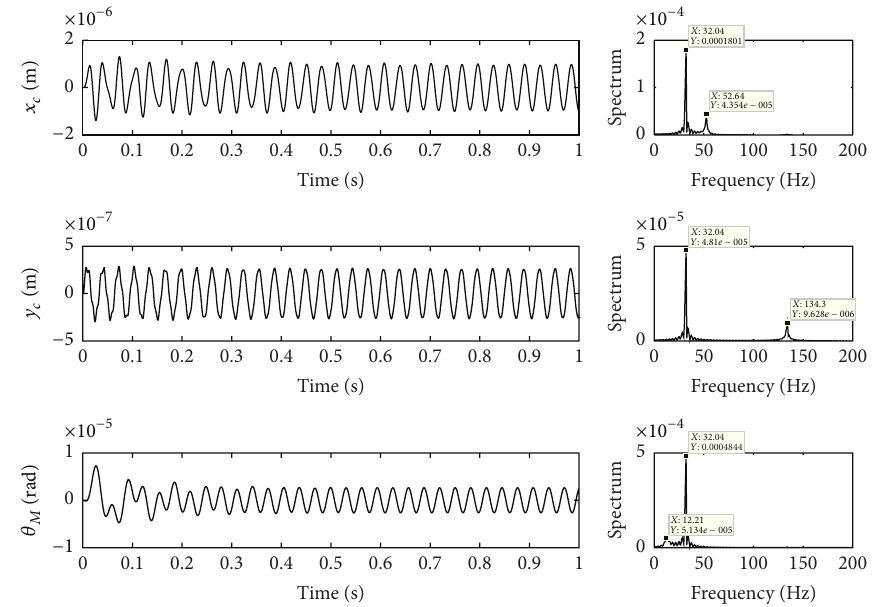
Figure 10: Dynamic response to periodic disturbance of strip entry thickness for V 𝑟 = 20 m/s.